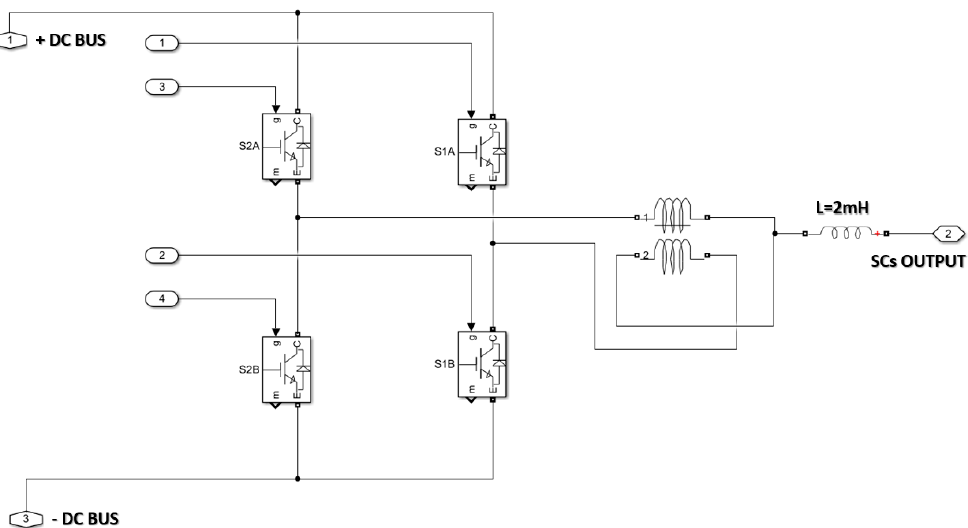
Figure 22. Internal structure of the two-way DC/DC converter.